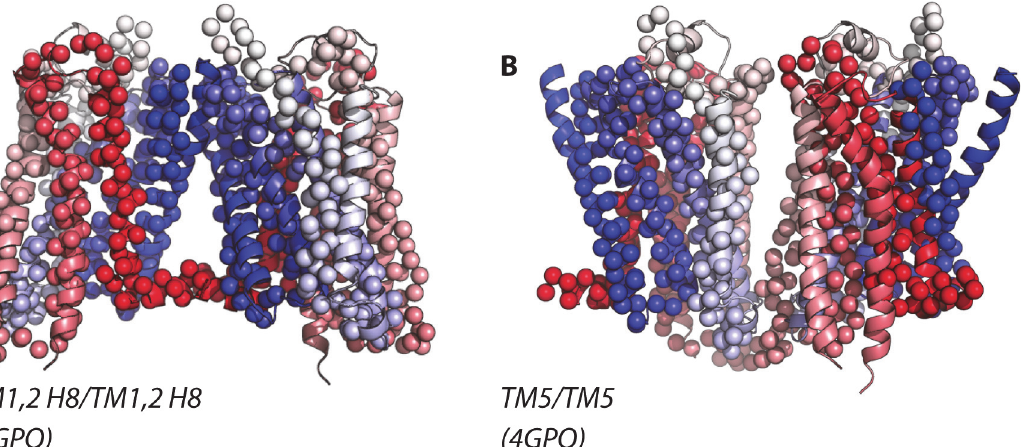
Fig 4. Superposition of the highly frequent homo-dimer configurations of μ -OR onto the closest available crystal structures of parallel receptors. Specifically, these are: TM1,2,H8/TM1,2,H8 and TM5/TM5 in panels A (RMSD of 5.92 Å from 4GPO) and B (RMSD of 8.82 Å from 4GPO),